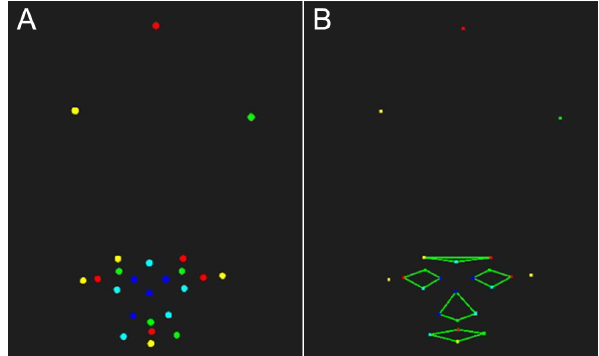
Figure 5. A, online reconstruction; B, offline reconstruction.